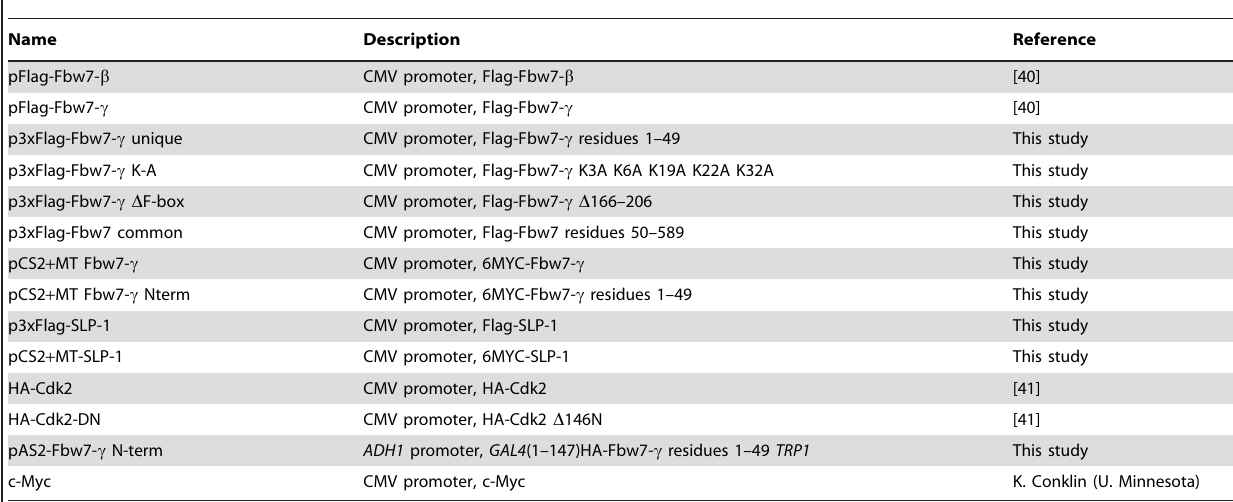
Table 1. Plasmids used in this